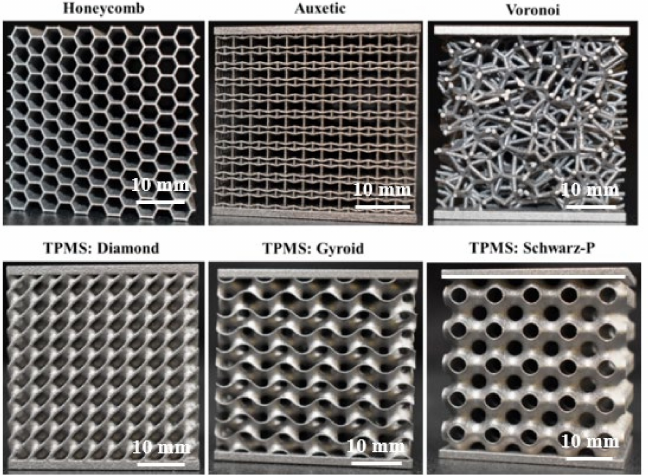
Figure 4. Images of fabricated specimens for each of the six cell types showing good reproduction of design